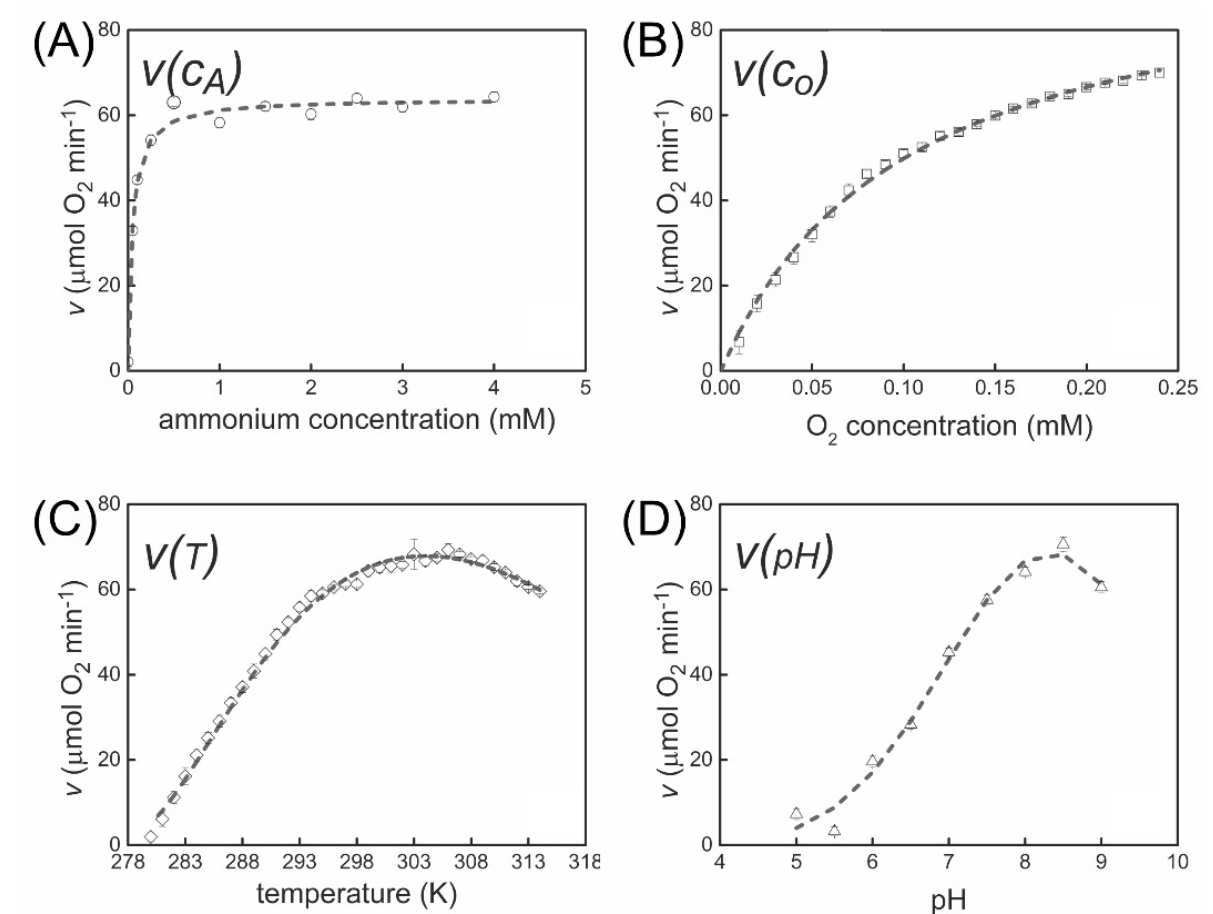
Figure 2. Rate of ammonium oxidation by AOB. Dependence of the rate on: ( A ) ammonium v(c A ) . ( B ) Oxygen v(c O ) concentration (Michaelis–Menten models). ( C ) Temperature v(T) modelled with Schoolfield and ( D ) pH v(pH) modelled with the GausAmp equation. Experimental data are marked with symbols (error bars SD), and fitted model curves are marked with dotted lines.